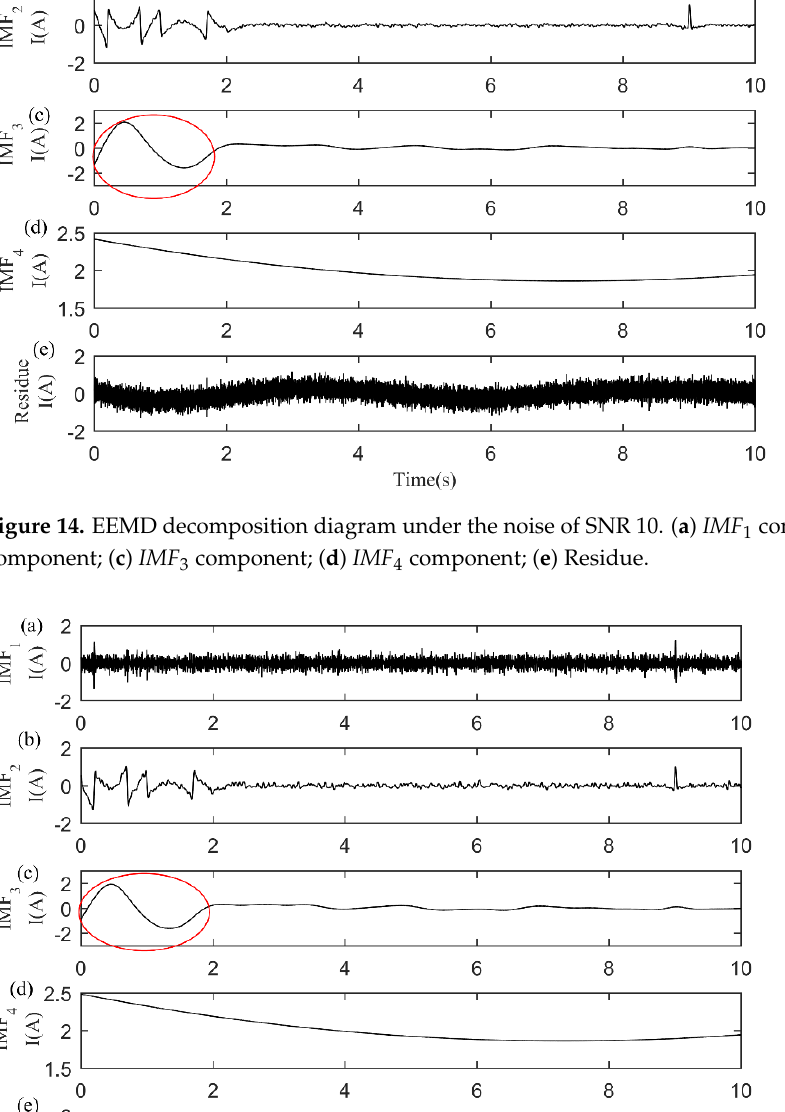
component; ( c ) IMF 3 component; ( d ) Residue.